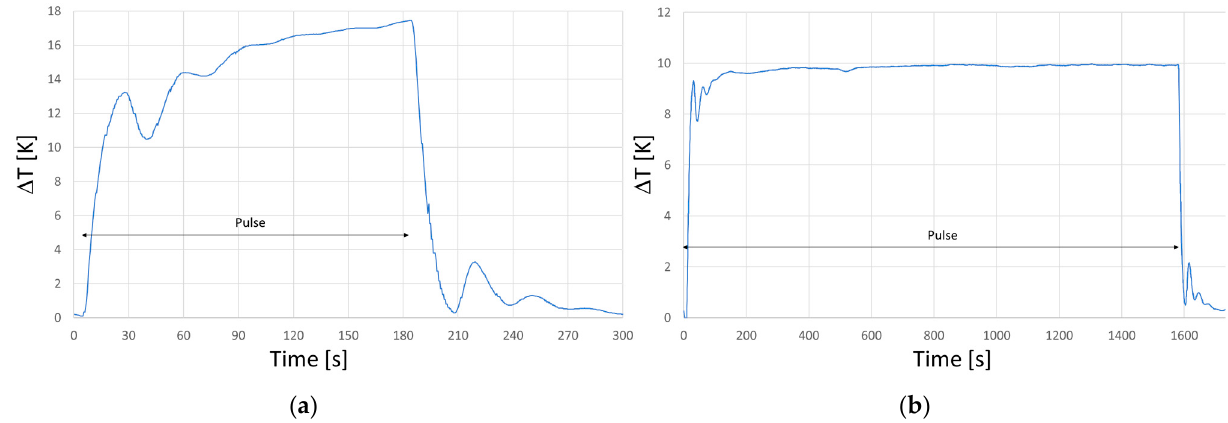
Figure 13. Cooling water temperature during a shot with 180 s pulse duration ( a ). Cooling water temperature during a shot with 1571 s pulse duration ( b ).